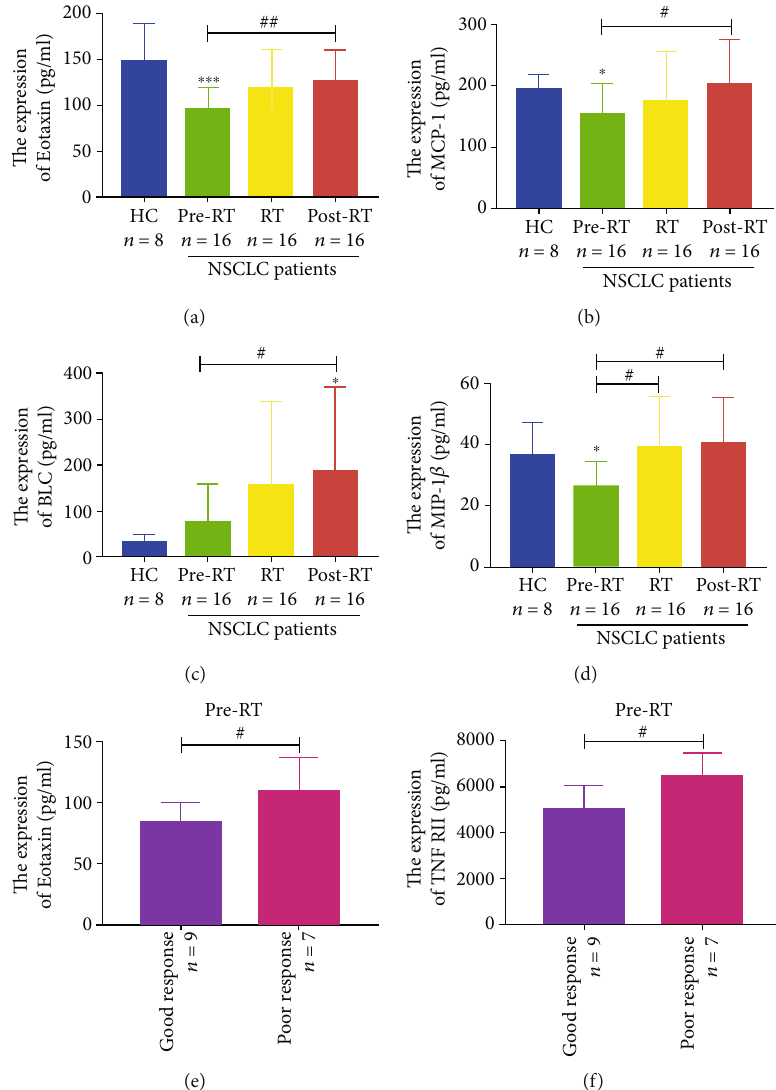
Figure 7: The expressions of plasma cytokines in HC and NSCLC patients. (a – d) The expressions of eotaxin, MCP-1, BLC, and MIP-1 β in HC and NSCLC patients. (e, f) Histogram of the expressions of eotaxin and TNF RII in the good and poor response groups. ∗ p < 0 : 05 , ∗∗ p < 0 : 01 , ∗∗∗ p < 0 : 001 , and ∗∗∗∗ p < 0 : 0001 compared with the HC group. # p < 0 : 05 and ## p < 0 : 01 . The bars denote mean ± SD